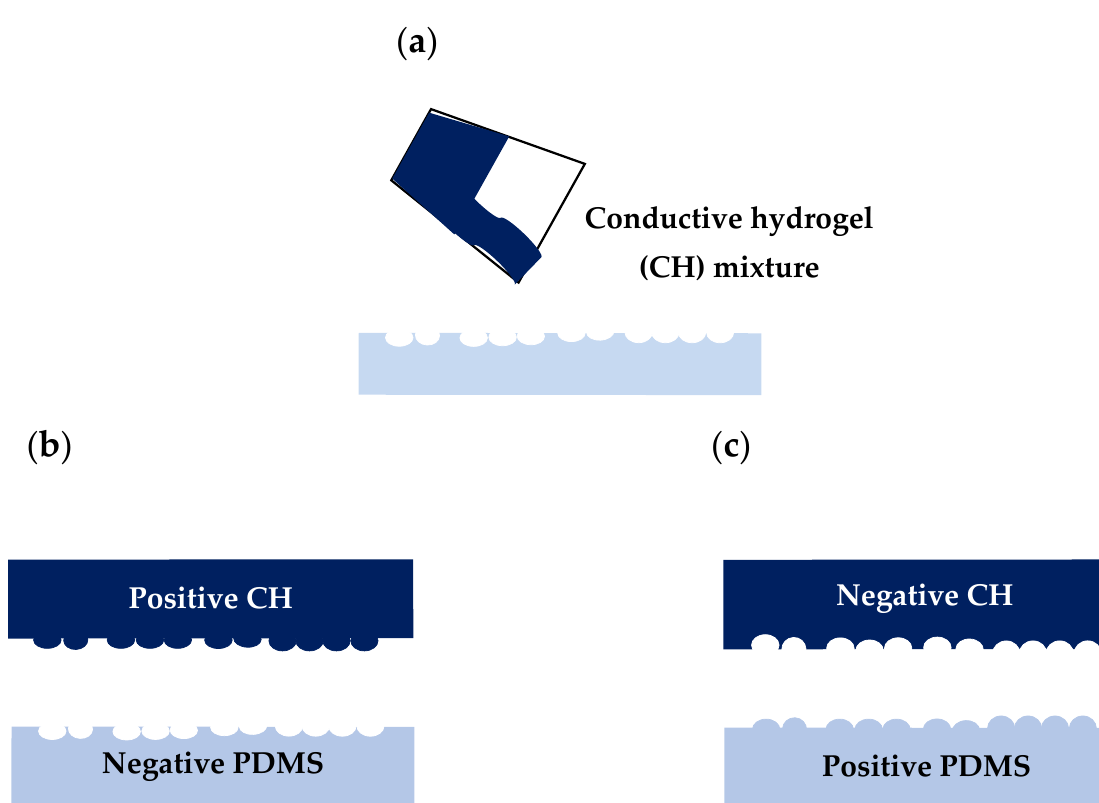
Figure 2. Schematic of conductive hydrogel with positive and negative bioimprints: ( a ) CH mixture is liquid cast on PDMS moulds with negative and positive bioimprints and left in the incubator at 37 °C overnight, then further cured at 4 °C for 48 h, ( b ) negative and positive CH moulds are peeled off the PDMS mould, ( c ), positive CH and negative PDMS replicas produced by soft lithography process.